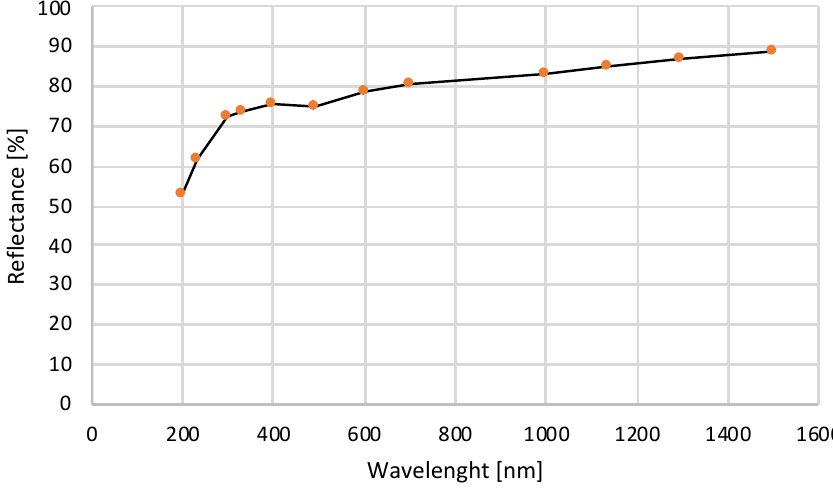
Figure 5. Rhodium coating reflectance as a function of incident light wavelength.